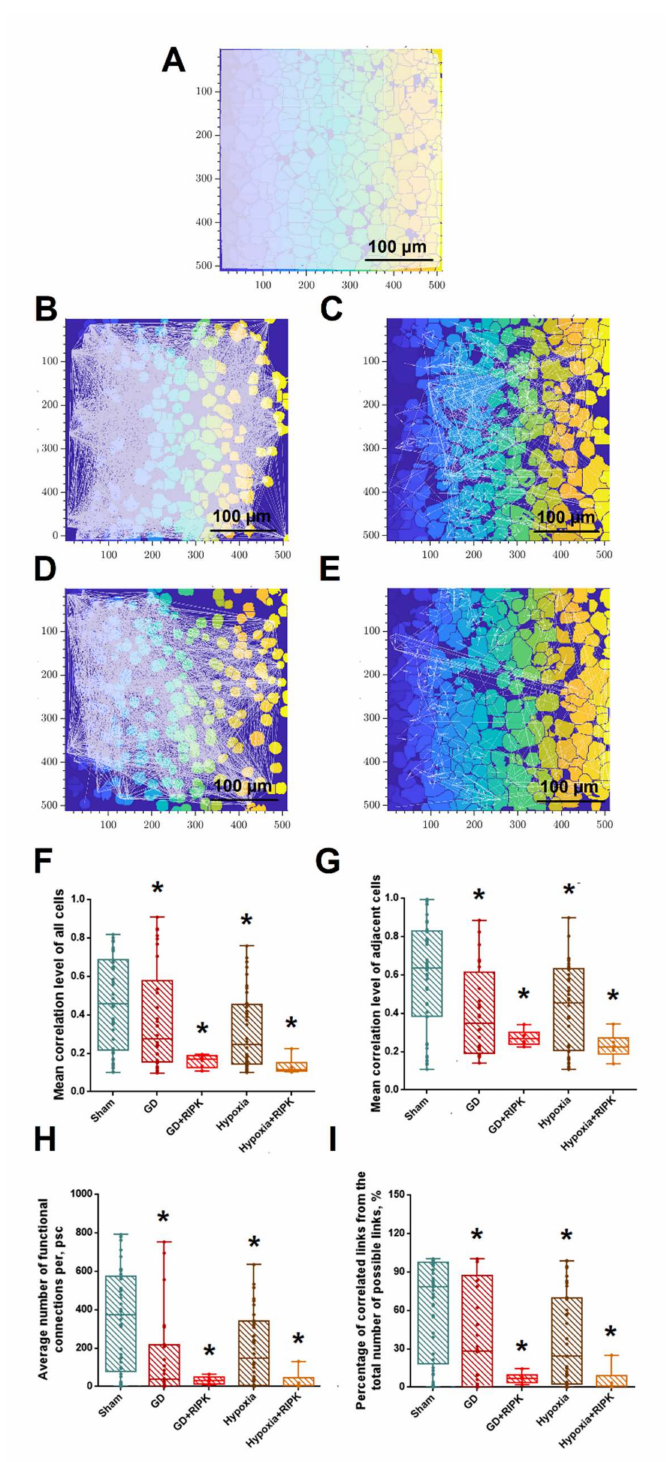
Figure 3. ( A – E ) Representative correlation network graphs with a threshold of >0.3. ( A )—Sham, ( B )—GD, ( C )—GD + RIPK1, ( D )—Hypoxia, and ( E )—Hypoxia + RIPK1. ( F – I )—Reorganization of neuron-glial network activity in primary hippocampal cultures: ( F )—the level of correlation of all cells. F= 5.42. Sham vs. GD p = 0.044; Sham vs. GD + RIPK p = 0.009; GD vs. GD + RIPK—NS; Sham vs. Hypoxia p = 0.038. Sham vs. Hypoxia + RIPK p = 0.024; Hypoxia vs. Hypoxia + RIPK—NS; ( G )—the level of correlation of neighboring cells. F= 6.19. Sham vs. GD p = 0.024; Sham vs. GD + RIPK p = 0.007; GD vs. GD + RIPK—NS; Sham vs. Hypoxia p = 0.016. Sham vs. Hypoxia + RIPK p = 0.041; Hypoxia vs. Hypoxia + RIPK—NS; ( H )—the number of functional connections per